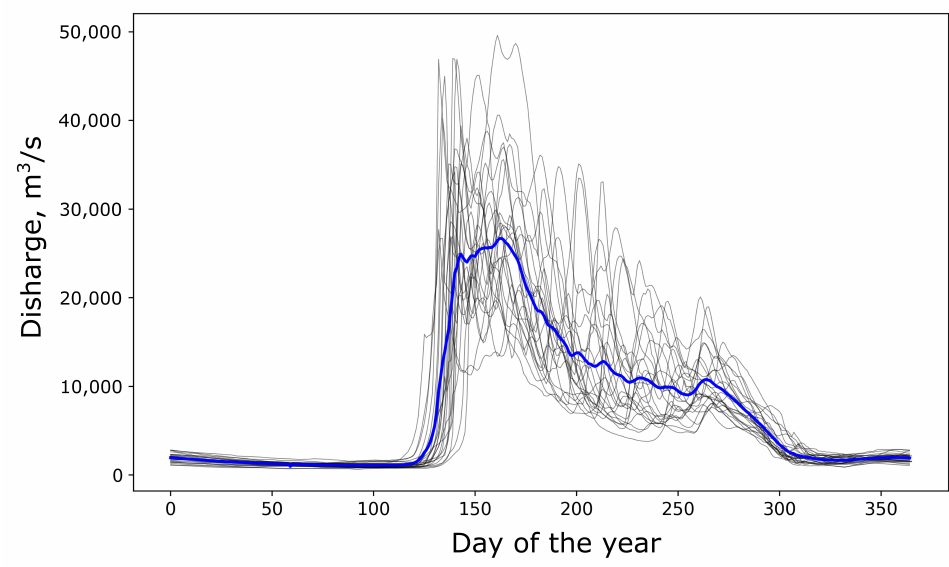
Figure 2. Flow graph for “Tabaga” hydro gauge on the Lena River. The blue line shows the average values for the period from 1985 to 2011. The black lines show the values of river flow for specific times each